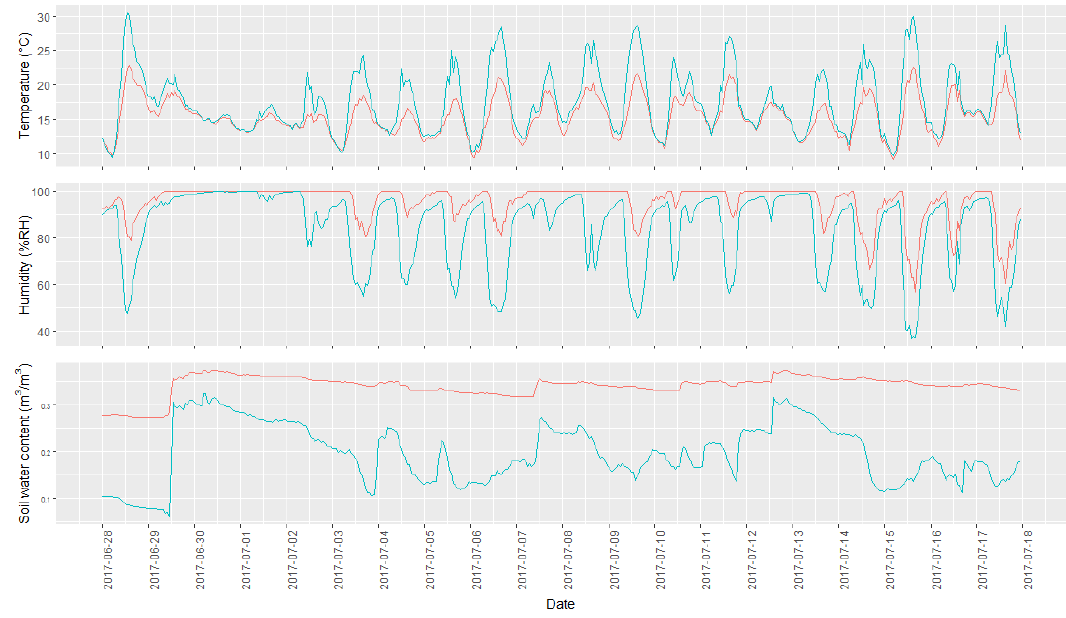
Figure 3. Overview of the range of observed microclimatic data collected during the studies time with an hourly resolution. The two lines represent the data from the sampling points with the highest and lowest average per microclimatic condition. The green line represents the sampling point with the highest temperature and lowest humidity, while the red line represents the sampling point characterized by a lower air temperature and higher air humidity. In the top graph, the temperature profile is shown, in the middle the humidity profile, and at the bottom the soil water content.